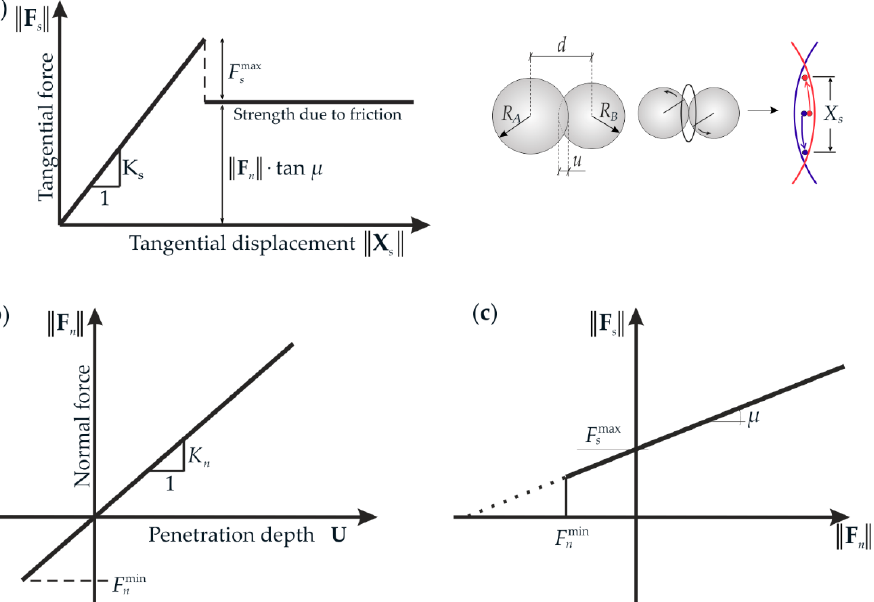
Figure 1. Mechanical response of DEM: ( a ) tangential contact model, ( b ) normal contact model, and ( c ) modified Mohr-Coulomb model [29].